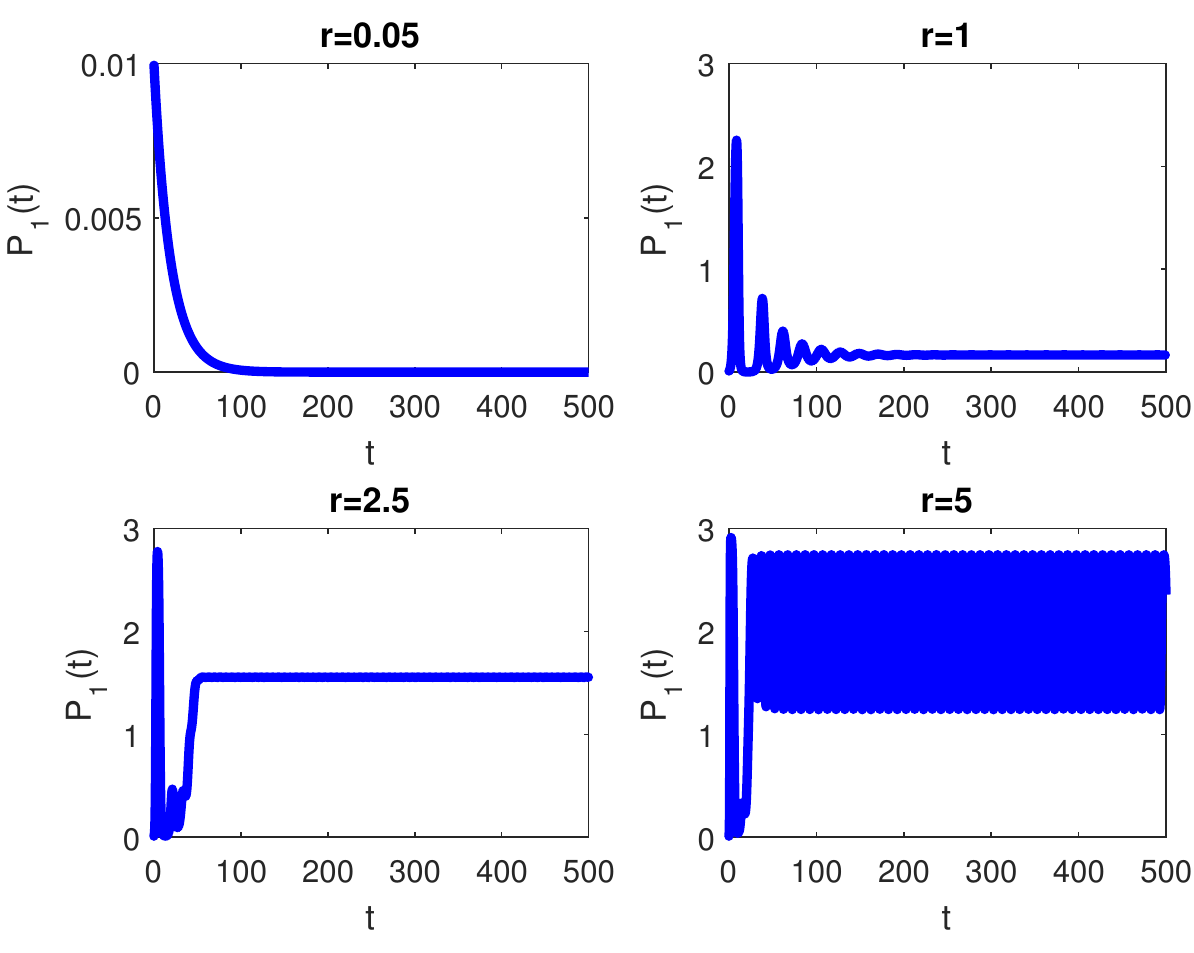
Figure 5. The RPW system (1) with r = 0.05, 1, 2.5,